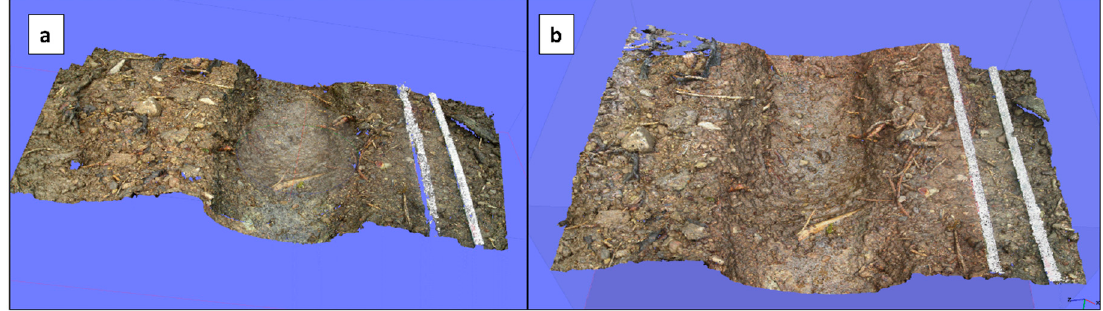
Figure 5. Comparison of meshes by the stereo device ( a ) and the Quadro device ( b ).